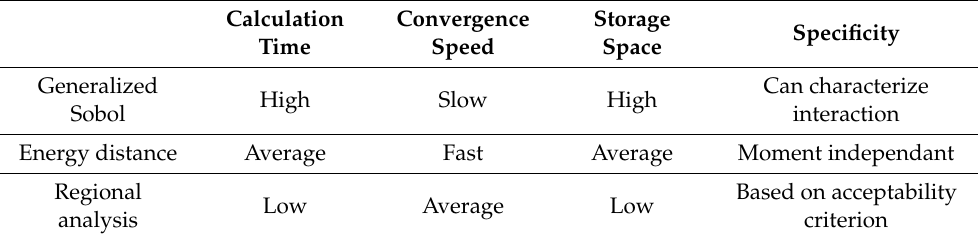
Table 3. Performances and specificity of the different